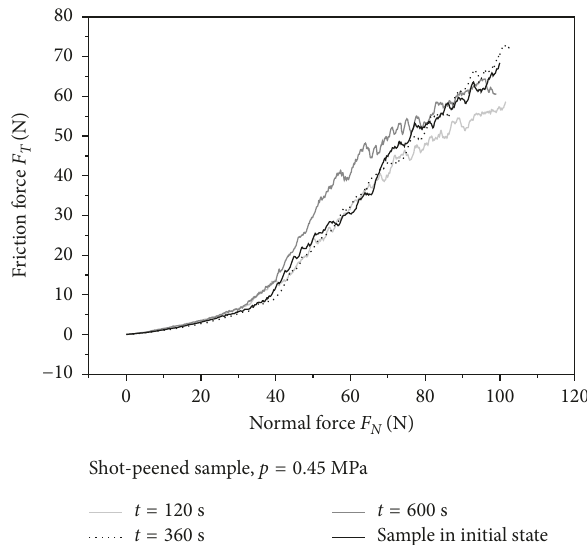
Figure 13: The friction force for a progressive load scratch test on CrN coating deposited on substrate without shot peening and after shot peening with different treatment parameters plotted versus the applied load.